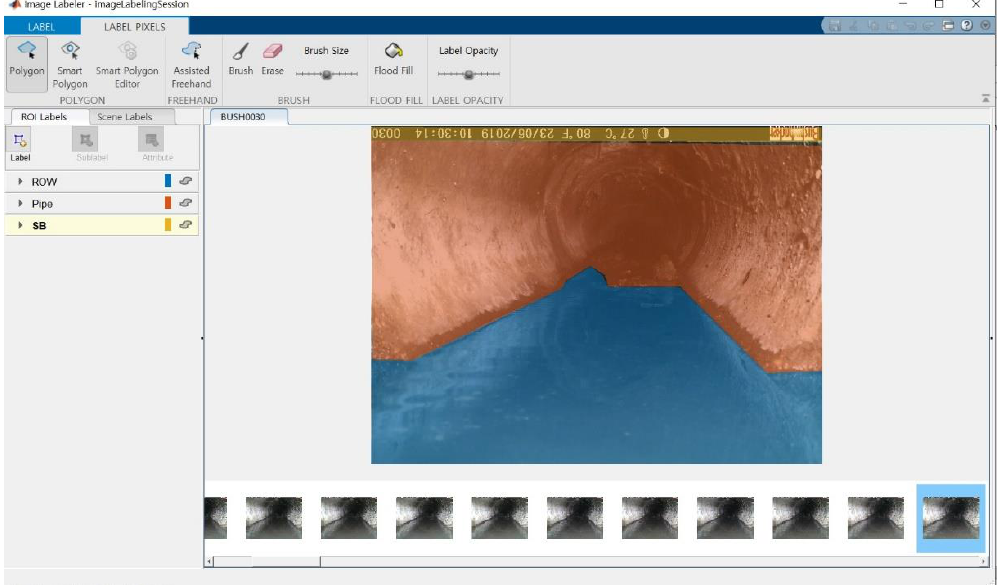
Figure 3. Labeling images to region of water (ROW), pipe, and status bar (SB) using Image Labeler in MATLAB.